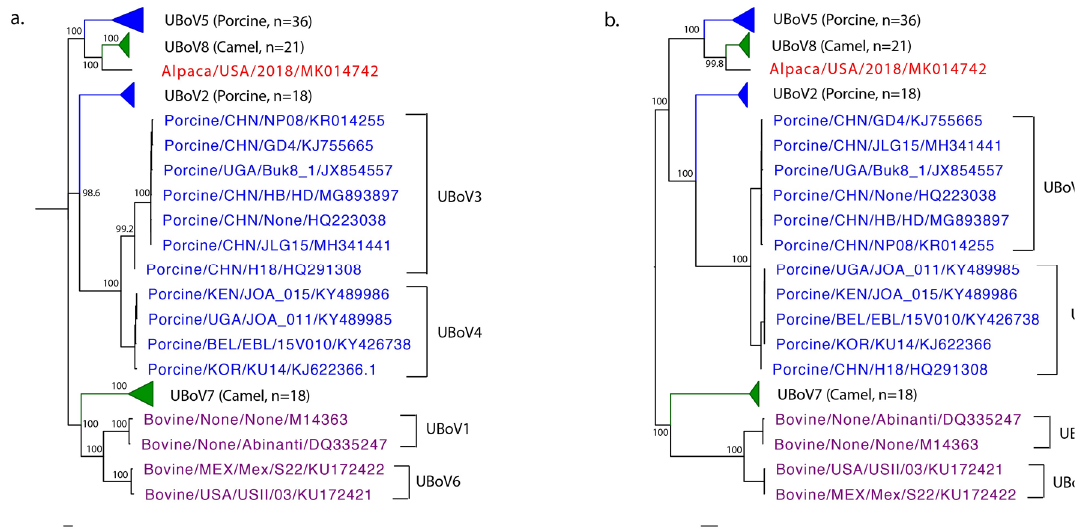
Figure 3. Mid-root Maximum Likelihood phylogenetic trees of AlBoV and other UBoV strains in the GenBank. ( a ) Whole genome phylogenetic tree. ( b ) Phylogenetic tree of NS1 amino acid sequences. Bootstrap values are indicated for major nodes. AlBoV is represented in red while the porcine, camel, and bovine UBoV strains are represented in blue, green, and purple, respectively.